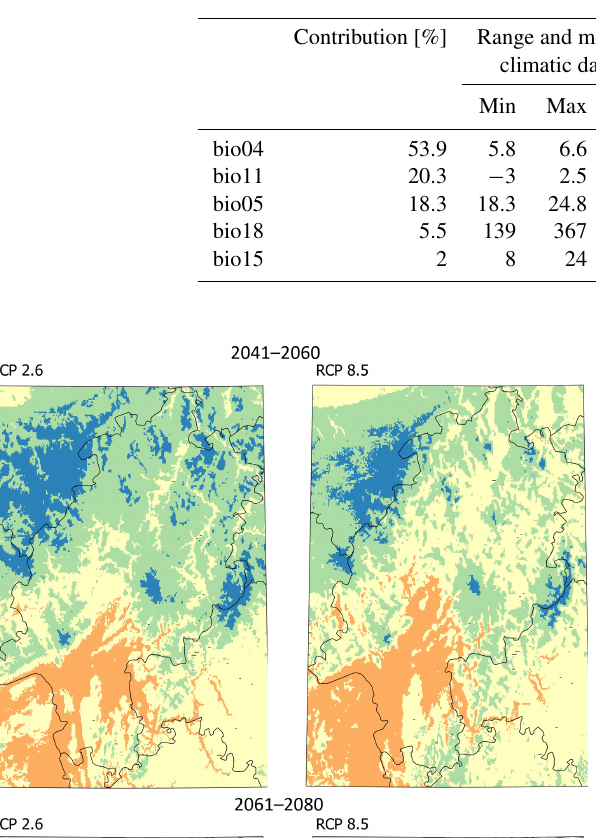
Table 2. Range and mean values of climatic variables included in the baseline model for Hesse as well as the range of values for these variables from locations with records of Mantis religiosa . Bio04 is temperature seasonality (standard deviation), bio05 is max temperature of warmest month ( ◦ C]), bio11 is mean temperature of the coldest quarter ( ◦ C), bio15 is precipitation seasonality (coefficient of variation), and bio18 is precipitation of the warmest quarter (mm per quarter).